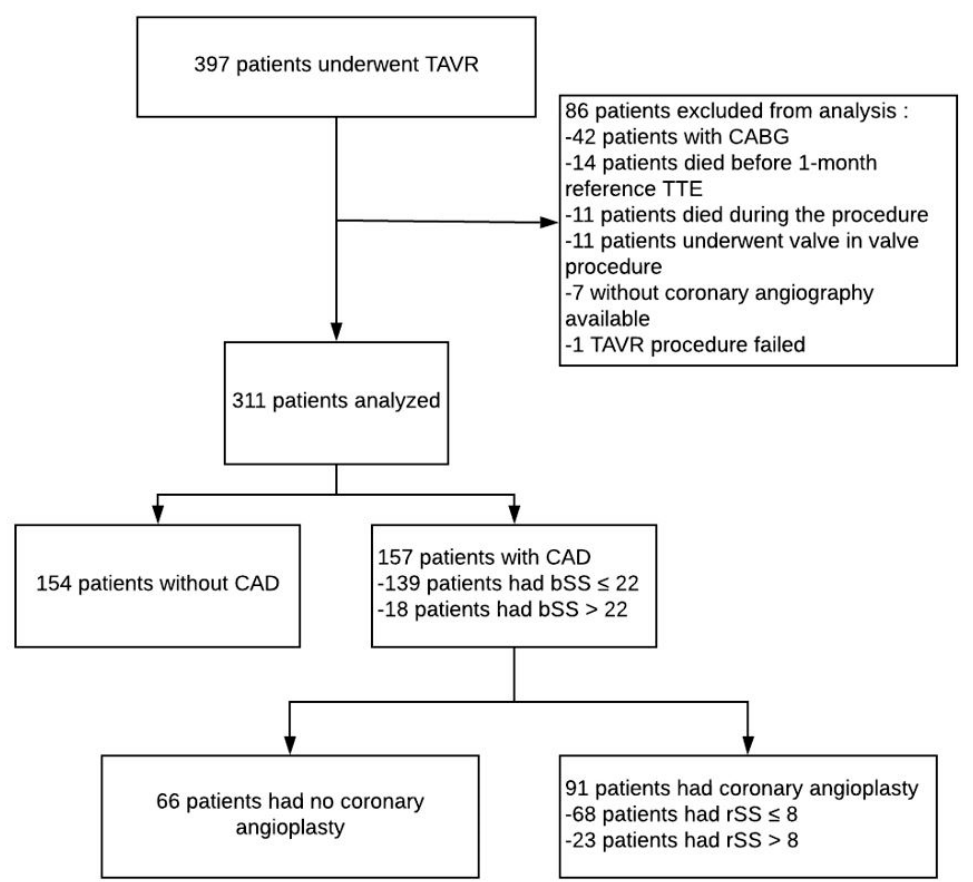
Figure 1. Flow chart of the study. bSS: baseline SYNTAX score, CABG: coronary artery bypass, CAD: coronary artery disease, CT-ADP: closure time adenosine diphosphate, rSS: residual SYNTAX score, TAVR: Transcatheter aortic valve replacement, TTE: transthoracic echocardiography.